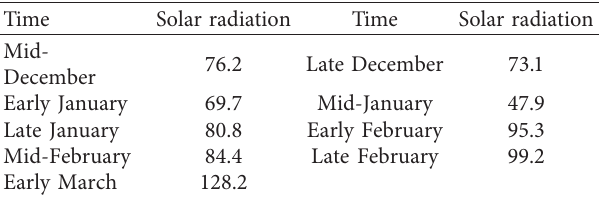
Table 2: Solar radiation in Bin County (MJ/m 2 ). Table 3: Climatic parameters of Bin